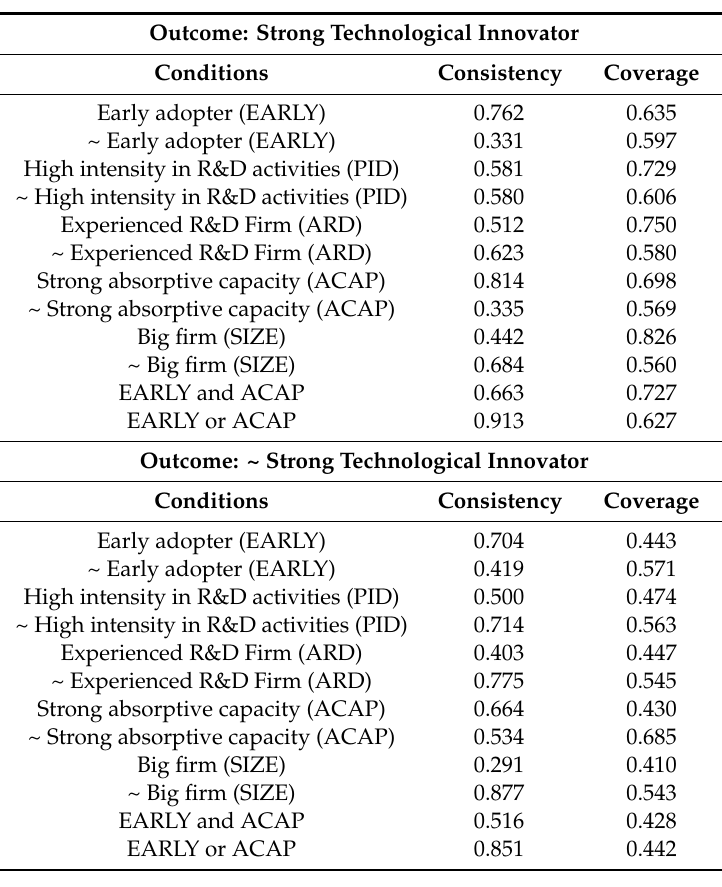
Table 4. Results of the necessity